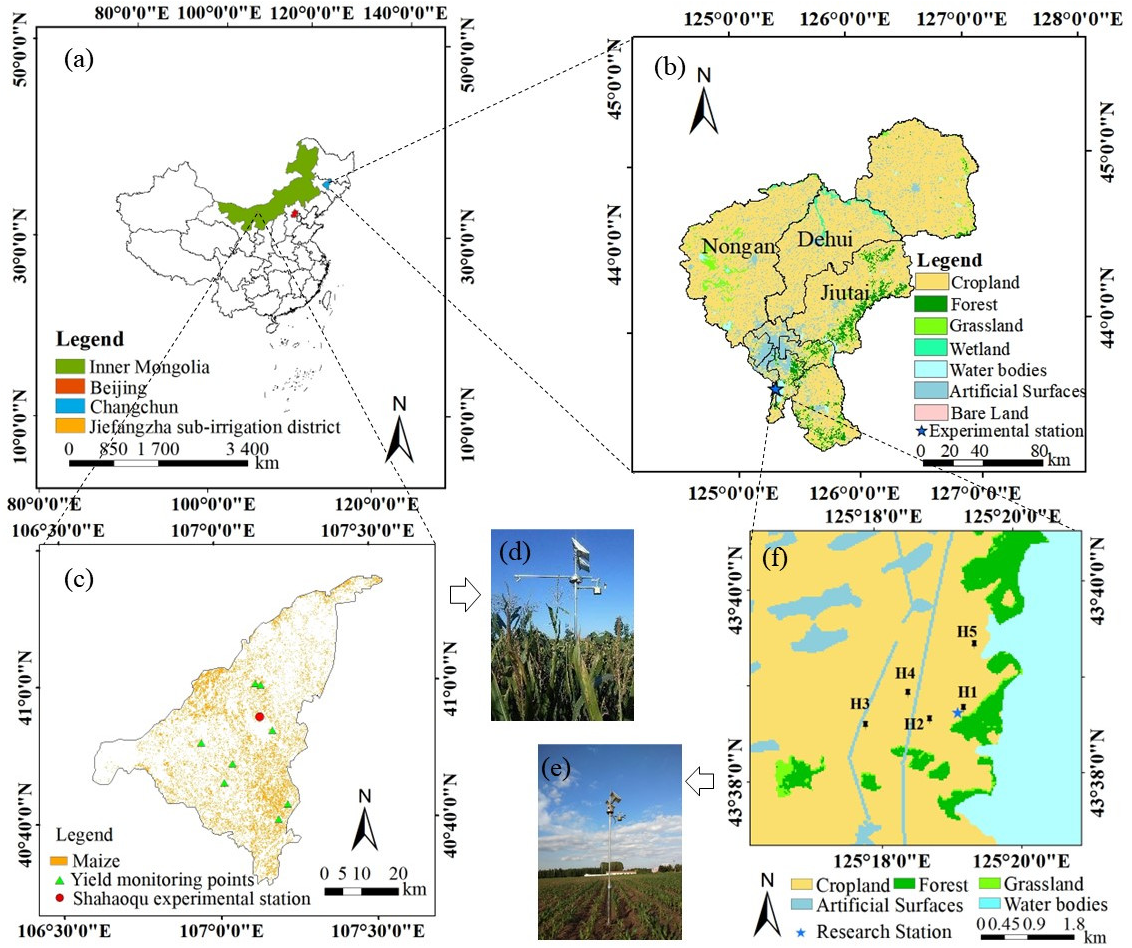
Figure 1. Overview of the two study areas: ( a ) locations in China; ( b ) land-use and -cover map in Changchun from the GlobeLand30 platform (in 2020); ( c ) distributions of experimental station and eight yield monitoring points in Jiefangzha sub-irrigation district; ( d , e ) a typical CTMS equipment in Jiefangzha/Changchun; ( f ) locations of the five sets of CTMS equipment (H1 to H5) in Changchun.